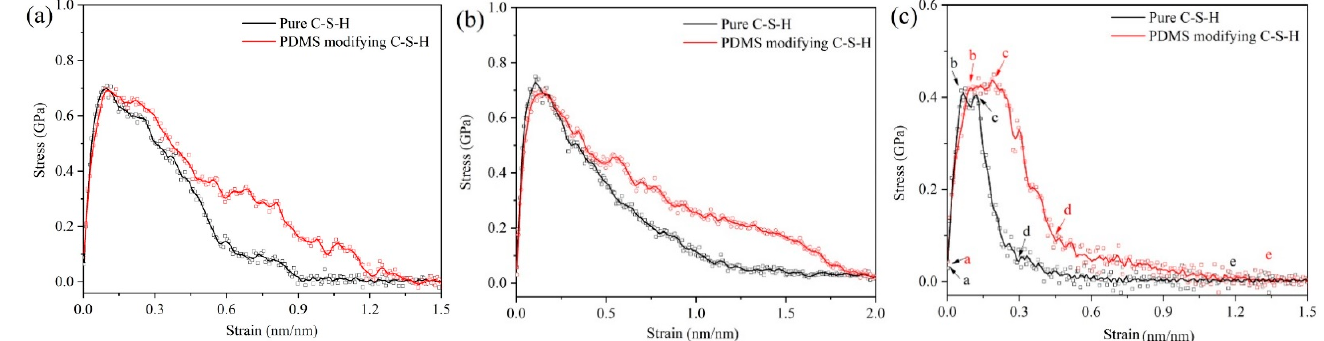
Figure 7. Tensile stress–strain curves for C-S-H and PDMS-modified C-S-H: along the ( a ) x -axis; ( b ) y -axis; ( c ) z -axis.